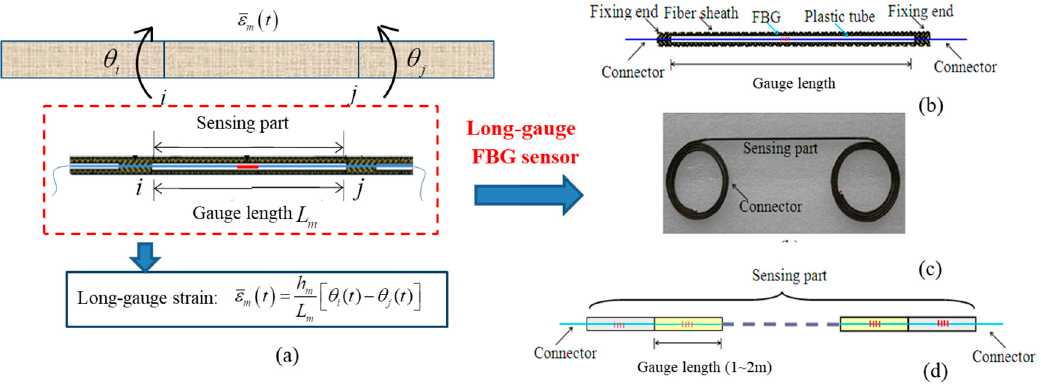
Figure 1. Fiber Bragg grating (FBG) sensor. ( a ) Principle of macrostrain; ( b ) Design of long-gauge FBG sensor; ( c ) Actual sensor; ( d ) Sensor arrays.